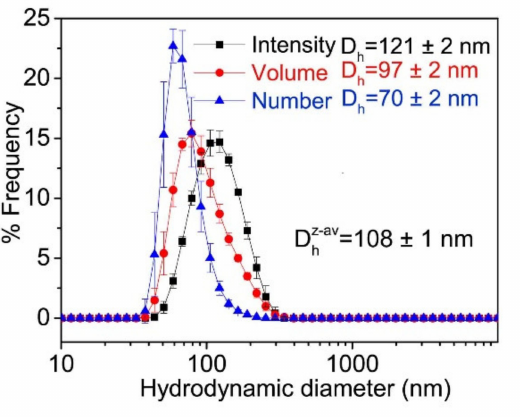
Figure 4. Hydrodynamic diameter distributions from DLS measurements for the MagP- NODAGA